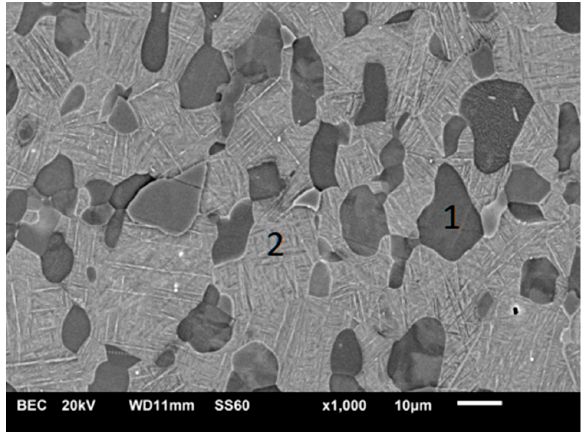
Figure 1. Bimodal microstructure of Ti-6Al-4V substrates. Phase marked 1—primary α phase, phase marked 2—transformed β phase.